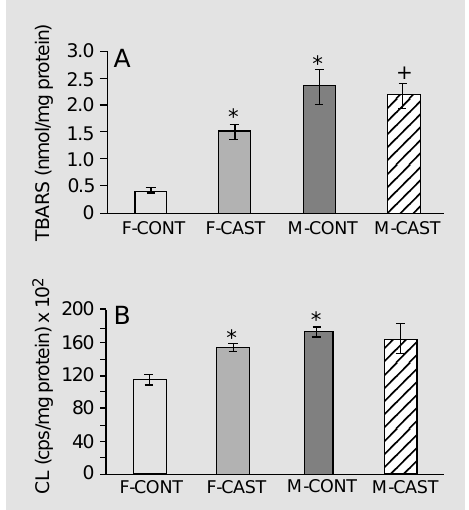
Figure 1. Lipid peroxidation. A , Thiobarbituric acid reactive substances (TBARS) in heart muscle homogenates from different groups (F = 18.53). B , Chemiluminescence